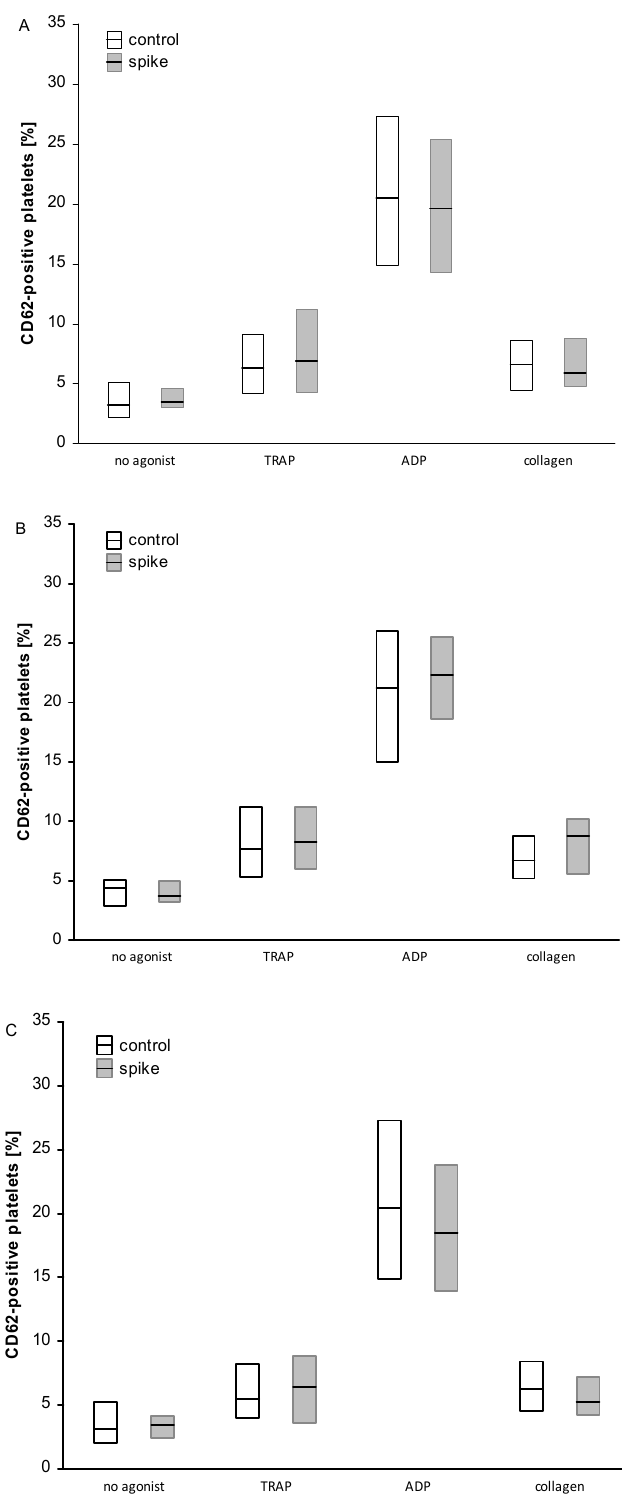
Figure 2. The effect of spike protein on CD62 exposure on the platelet surface membrane. Data are shown as median and interquartile range (Q1; Q3). The analysis was performed in all participants, n = 31 ( A ), in the High Ab-group, n = 13 ( B ), and in the Low Ab-group, n = 18 ( C ). No significant differences were observed between spike and control samples, irrespective of the concentration of nAb or type of agonist. The statistical significance of the differences between control vs. spike sample was estimated with the bootstrap-boosted paired Student’s t -test.